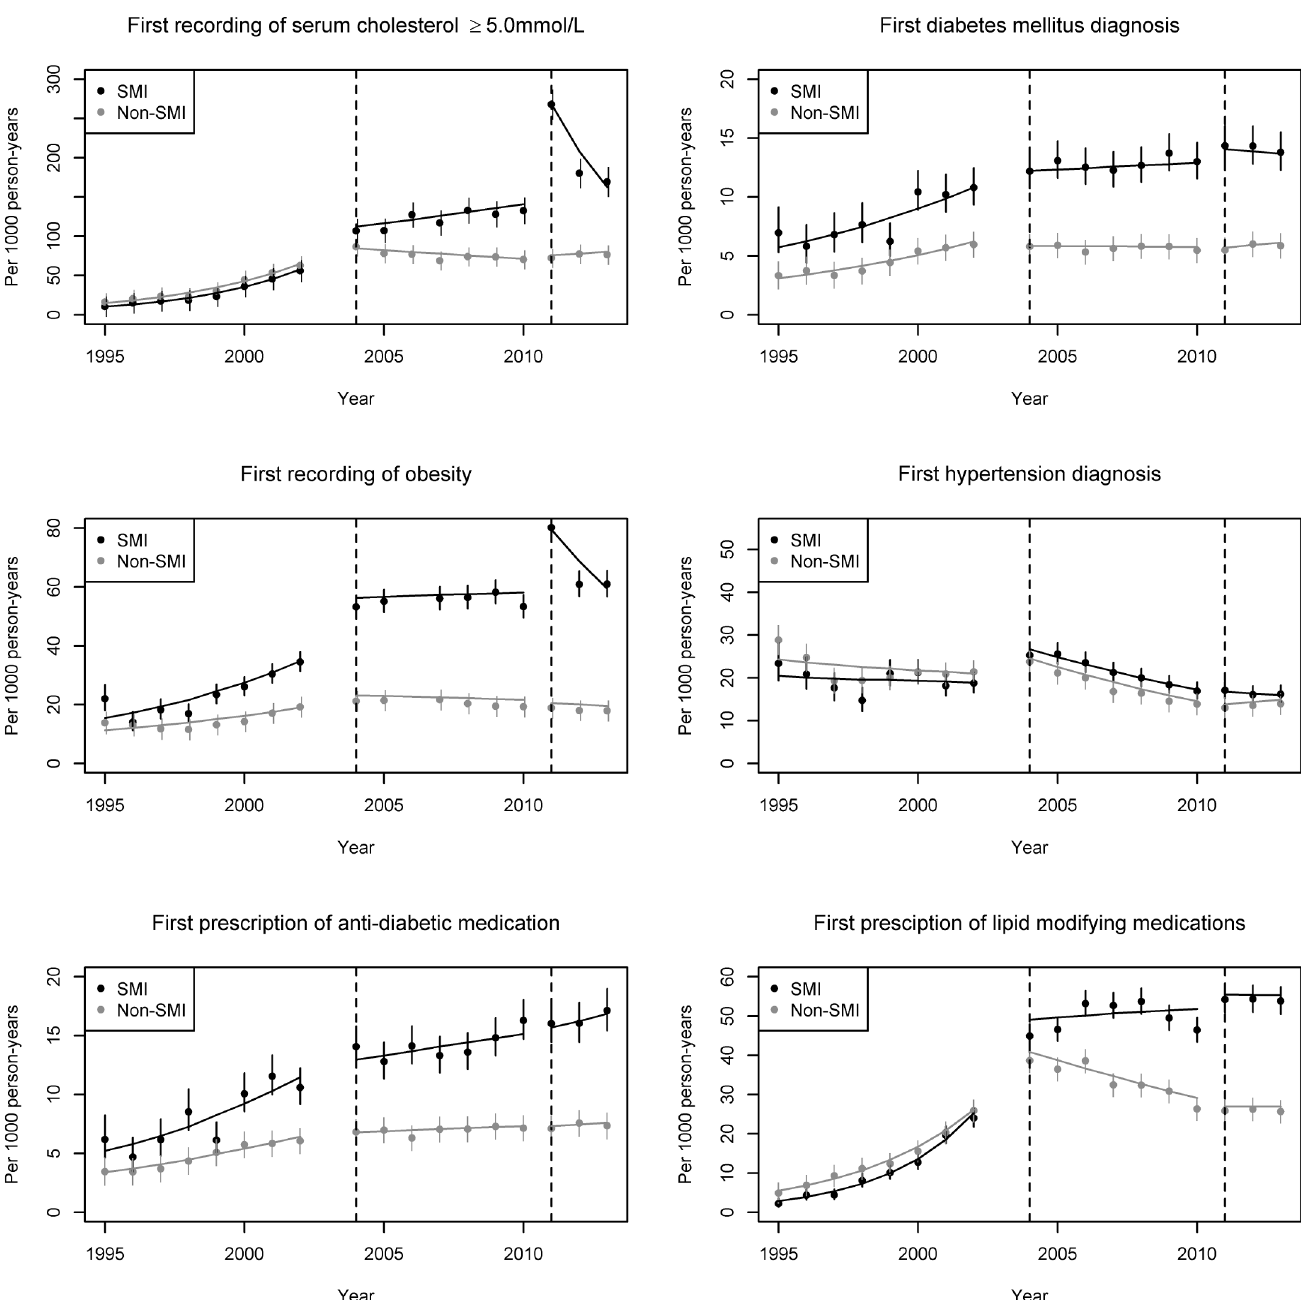
Fig 1. Outcomes over time for patients with and without severemental illness. SMI, severe mental illness. Dashedvertical lines indicatethe introductions of the Quality of Outcomes Framework (QOF) in 2004 and 2011.